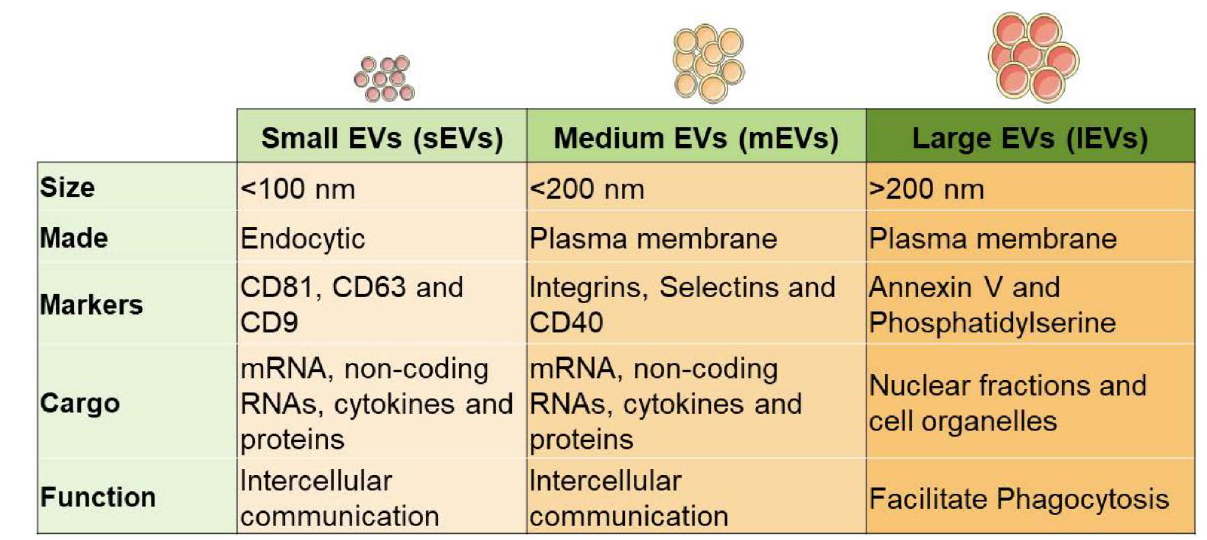
Figure 1. Main types of extracellular vesicles and their size, source, function, their biomarkers, and carrying cargo.